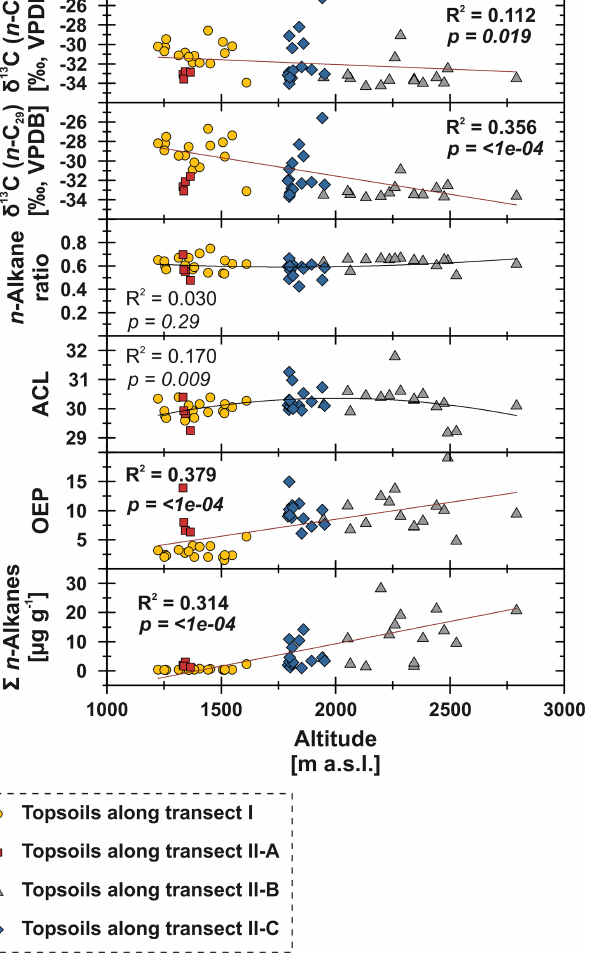
Figure 7. n -Alkane concentration ( n -C 25 – n -C 35 ), OEP, ACL, n -alkane ratio ( n -C 31 / ( n -C 29 + n -C 31 )) and compound-specific δ 13 C ( n -C 29 and n -C 31 ) from Mongolian topsoils plotted against altitude (ma.s.l.; Jarvis et al., 2008). Red trend lines illustrate linear regressions, and black lines illustrate polynomial regressions. Bold values indicate significance ( α = 0 .